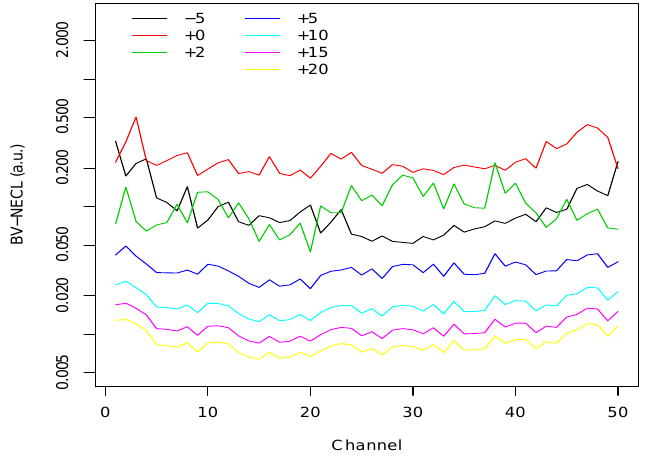
Figure 4. Segmented Basis Vector NECL Values: Group 3. NECL values for the 50 unit vectors (corresponding to the 50 spectral channels) were computed at 7 different plume temperatures from − 5 ◦ K to +20 ◦ K more than the average ground temperature 311 . 0 ◦ K. Only the pixels assigned to Group 3 were used in the calculations.